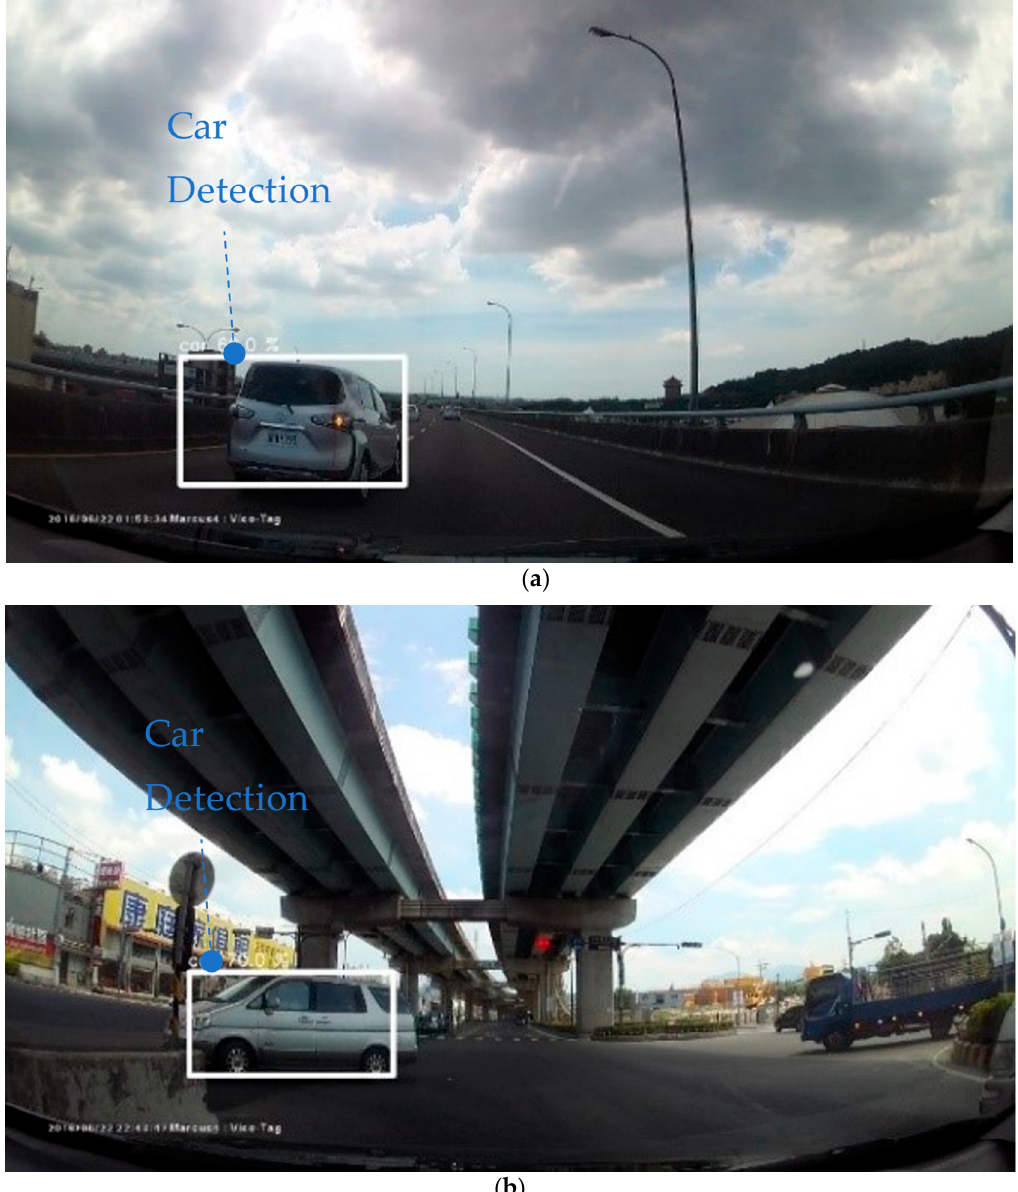
Figure 20. The results of the car detection. The figures are demonstrated in four rows: ( a ) and ( b ) are the results of car detection. Table 8. The training results of the car detection model.